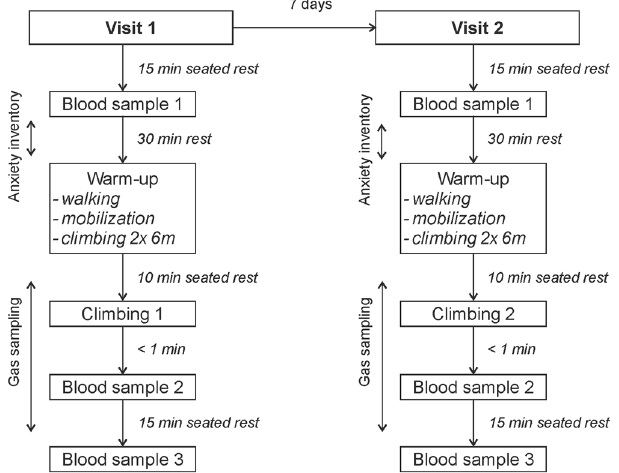
Figure 1. Experimental plan of the study with randomised climbing conditions—indoor wall or